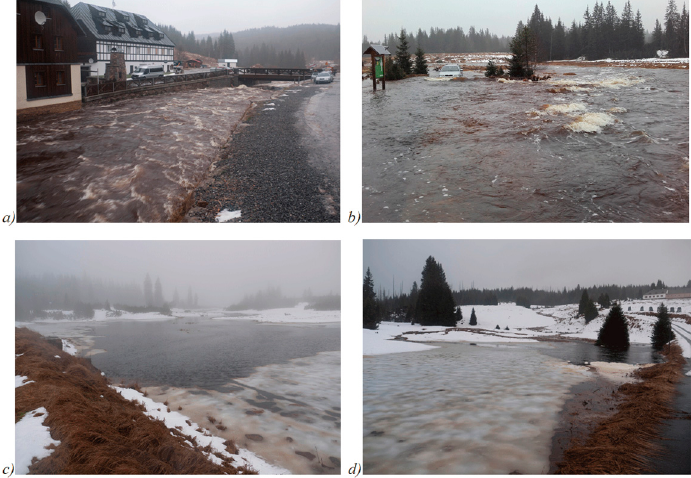
Figure 12. The course of the rain on snow flood on 1 December 2015, in different parts of the study area: ( a ) regulated channel at the basin outlet at Modrava (RKM); ( b ) flood spill in the large floodplain of JAV catchment; ( c ) flood filling the polder at ROK; and ( d ) ice jam at a road culvert at the headwaters (BRE) (Photo by Lukáš Vl č ek).